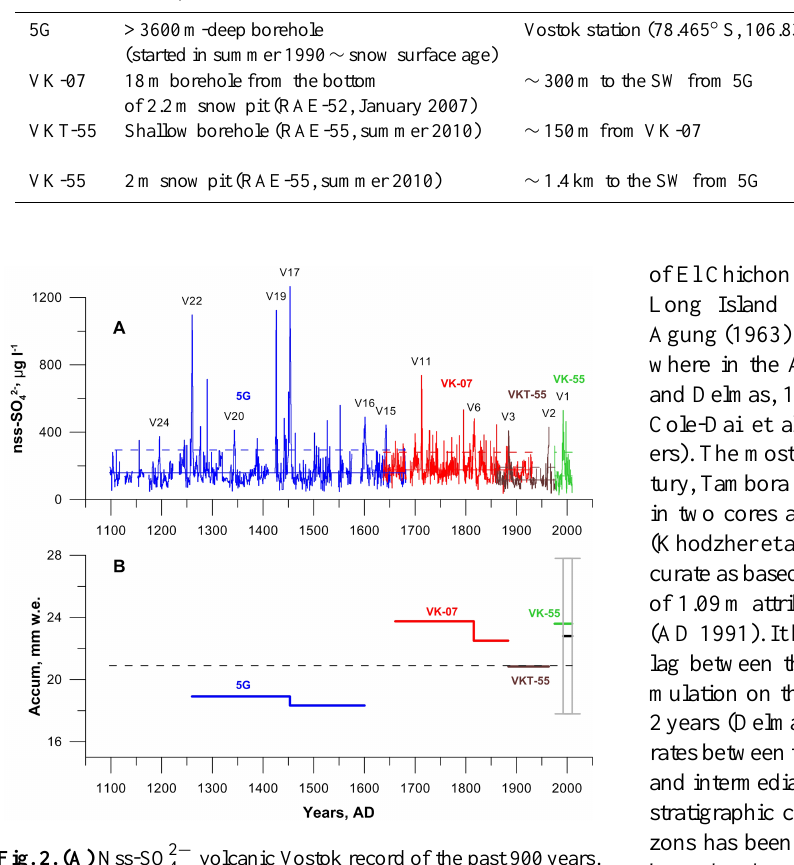
Fig. 2. (A) Nss-SO 2 − volcanic Vostok record of the past 900years. 4 Each of used four cores is shown by a different color (5G, VK- 07, VKT-55 and VK-55). Major volcanic eruptions are labeled (for more details see Table 3). Solid horizontal lines indicate a non- volcanic background and dashed lines show the detection thresh- old (explanations are in the text). (B) Accumulation rates calculated between the volcanic horizons in the studied cores. Black dashed line represents the long-term mean. Mean value of snow accumula- tion at Vostok station measured at the stack network for the period 1992–2010 is shown by a black horizontal line (vertical grey bars represent standard